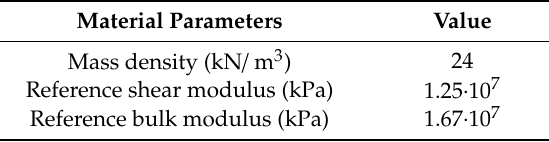
Table 6. Material parameters